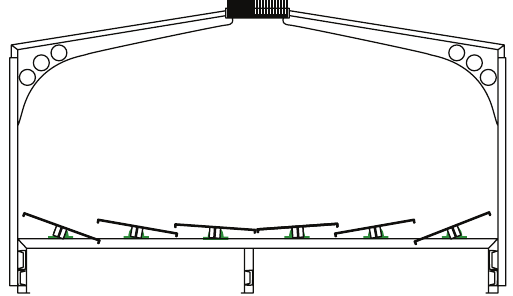
Figure 2: Frontal view of the low-concentration prototype.